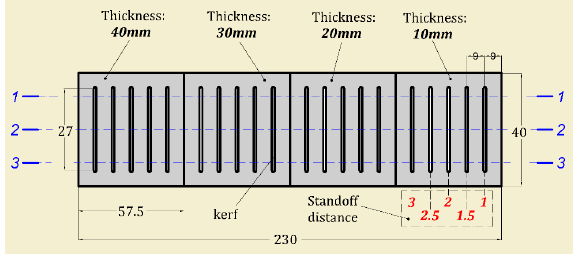
Figure 3. Schematic of material sample [11]